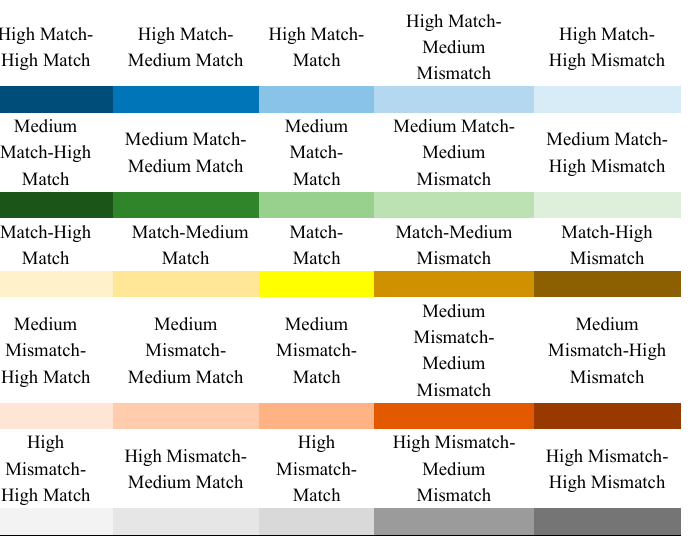
Figure 2. 5 × 5 City Types of ES Supply–demand Amount Index (ESAI) and ES Supply–demand Match Type Index (ESTI).